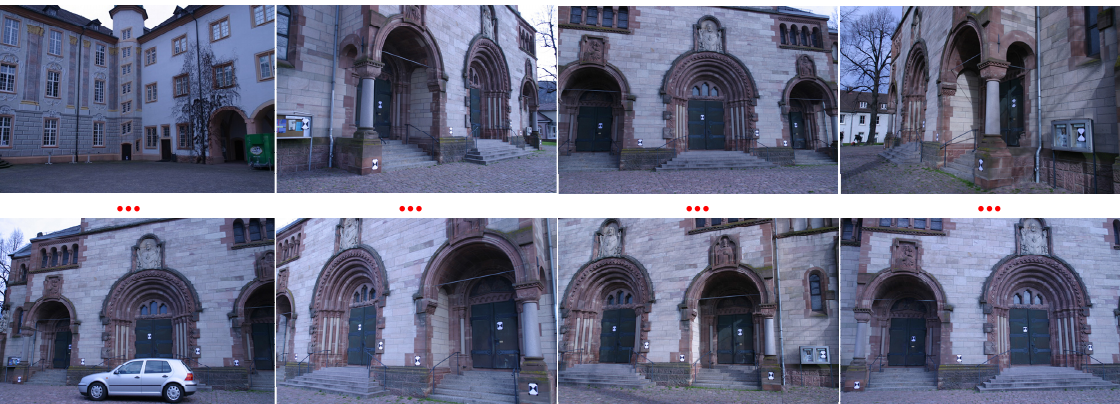
Figure 15. Samples of “Herz-Jesu-P25” in Strecha’s dataset. These images have many repeated fea- tures. This poses a challenge to the feature matching method.